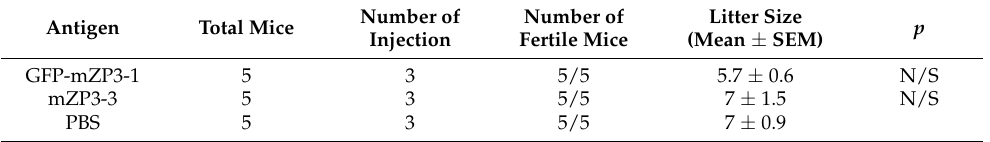
mice immunized with GFP-mZP3-1 (5.7 ± 0.6) and mZP3-3 (7 ± 1.5) were not significantly different from those of control mice (7 ± 0.9). Table 2. Fertility of BALB/c mice immunized with recombinant mZP3-based antigens Number of Number of Litter Size p Antigen Total Mice Injection Fertile Mice (Mean ± SEM) GFP-mZP3-1 5 3 5/5 5.7 ± 0.6 N/S mZP3-3 5 3 5/5 7 ± 1.5 N/S PBS 5 3 5/5 7 ± 0.9 Female BALB/c mice were immunized and boosted two times at three-week intervals with antigens in Polygen adjuvant and mated three weeks after the final boost. Values are means ± SEM. The p value indicates a significant difference ( p < 0.05) between the treated and control groups. N/S, not significant.